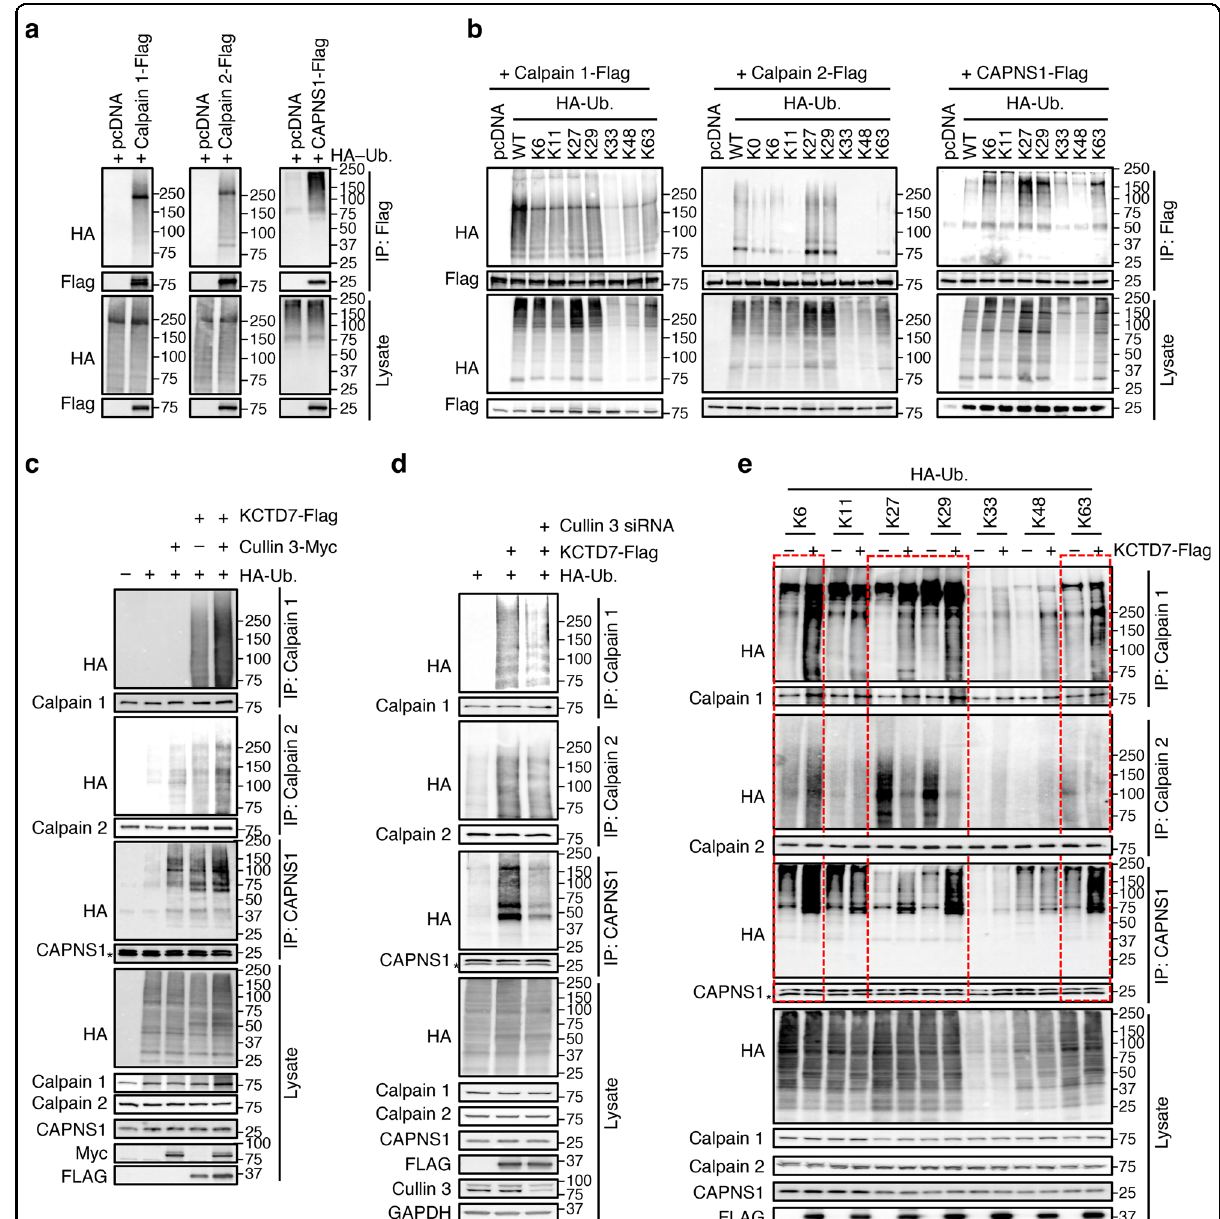
Fig. 3 KCTD7 – Cullin-3 ubiquitin ligase regulates calpain activity via atypical ubiquitination. a In vivo ubiquitination assay for calpain 1, calpain 2, and CAPNS1 performed by coexpressing either protein with HA-Ub in HEK293 cells for 36 h. b In vivo ubiquitination assay in HEK293 cells for calpain 1, calpain 2, and CAPNS1 using the indicated ubiquitin mutants. HA-Ub K0 has all lysine residues mutated. c In vivo ubiquitination assay for calpain 1, calpain 2, and CAPNS1 performed by expressing Cullin-3 and KCTD7 alone or in combination in HEK293 cells for 36 h. d In vivo ubiquitination assay for calpain 1, calpain 2, and CAPNS1 performed upon simultaneous expression of KCTD7 and knock-down of Cullin-3 in HEK293 cells for 48 h. e In vivo ubiquitination assay in HEK293 cells for calpain 1, calpain 2, and CAPNS1 performed by expressing the indicated ubiquitin mutants alone or in combination with